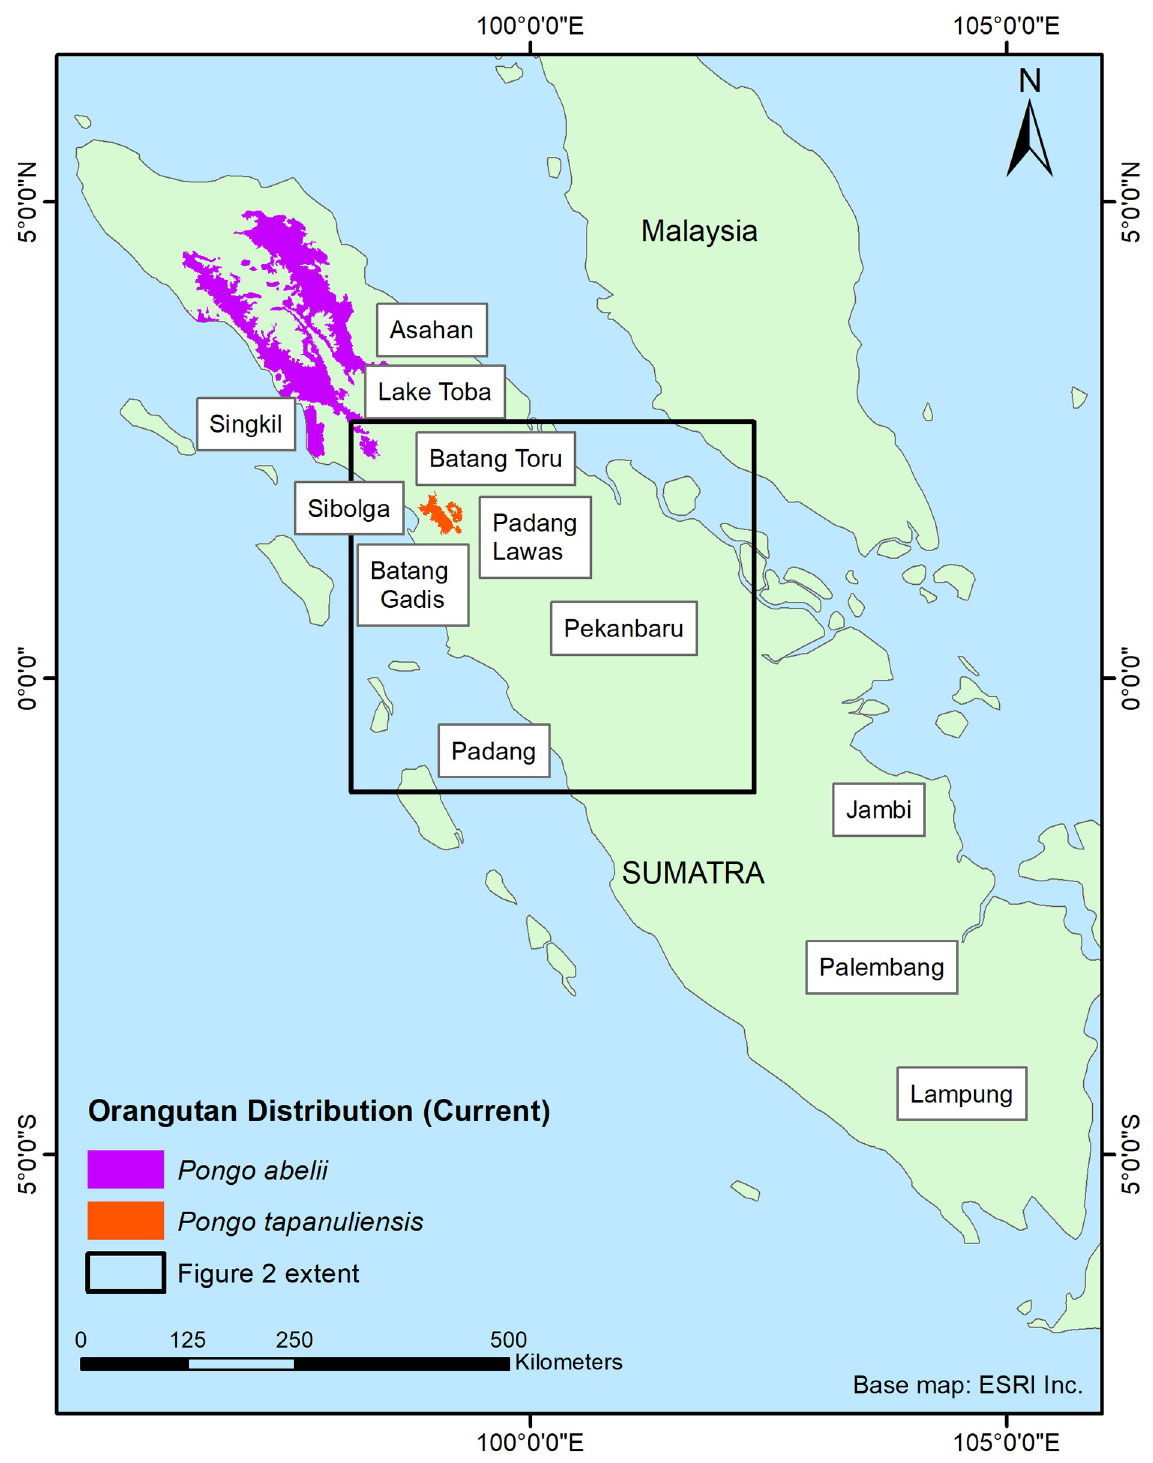
Fig 1. Map of the island of Sumatra, showing the current distribution ranges of P . tapanuliensis and P . abelii , and the main locations (cities, districts and other geographic features) mentioned in the text. The inset shows the area of Fig 2. Reprinted from [18] under a CC BY license, with permission from ESRI, original copyright 2000.